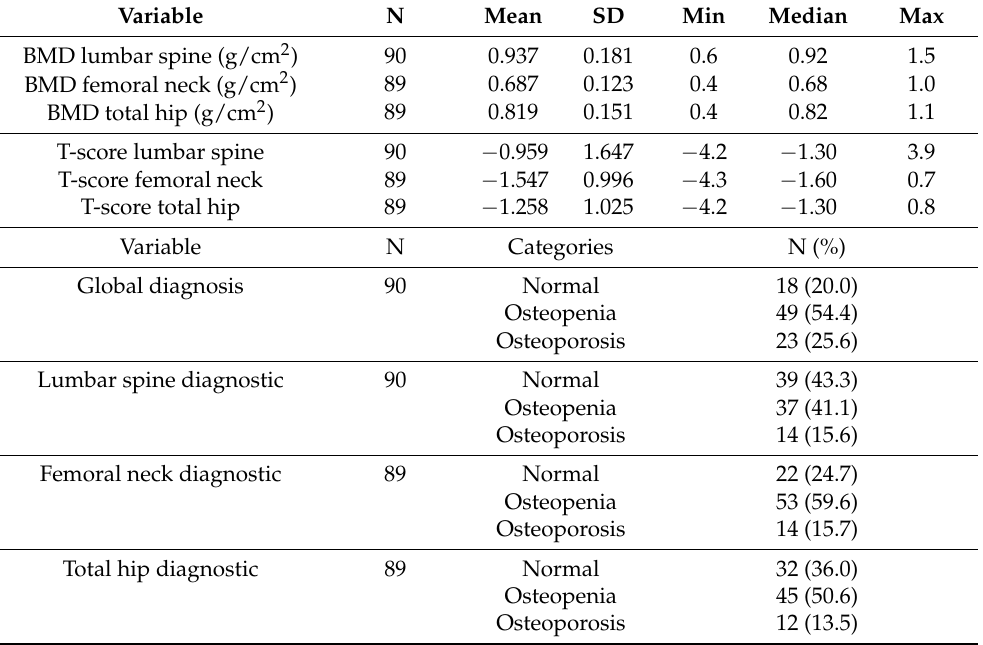
Table 2. Description of bone mineral density, T-scores and DEXA diagnosis (normal, osteopenia or